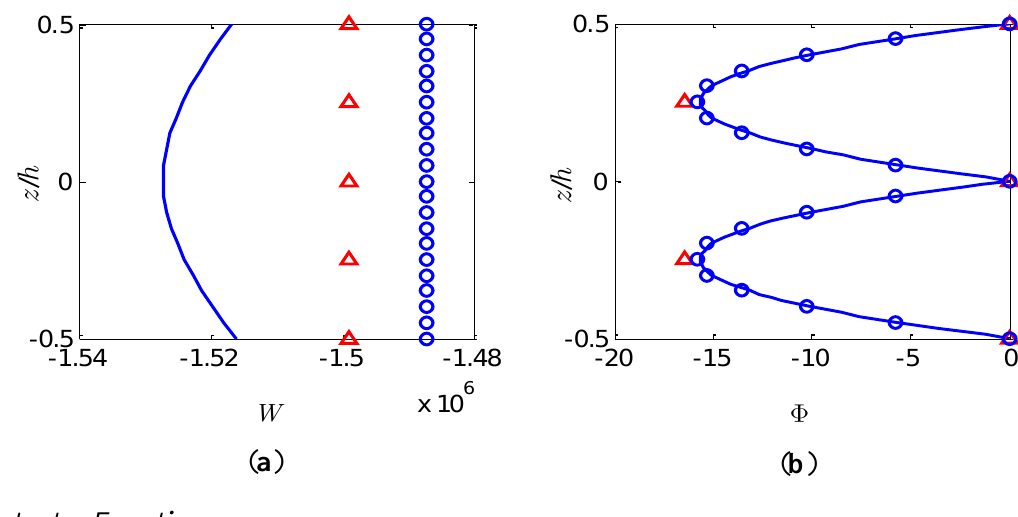
Figure 6. Bimorph sensor of 50 S under pressure load. ( a ) Dimensionless deflection; ( b ) Dimensionless electric potential. 3-D FE analysis (full line), present model with 2 n (triangles) and present model with 10 n (small circles).